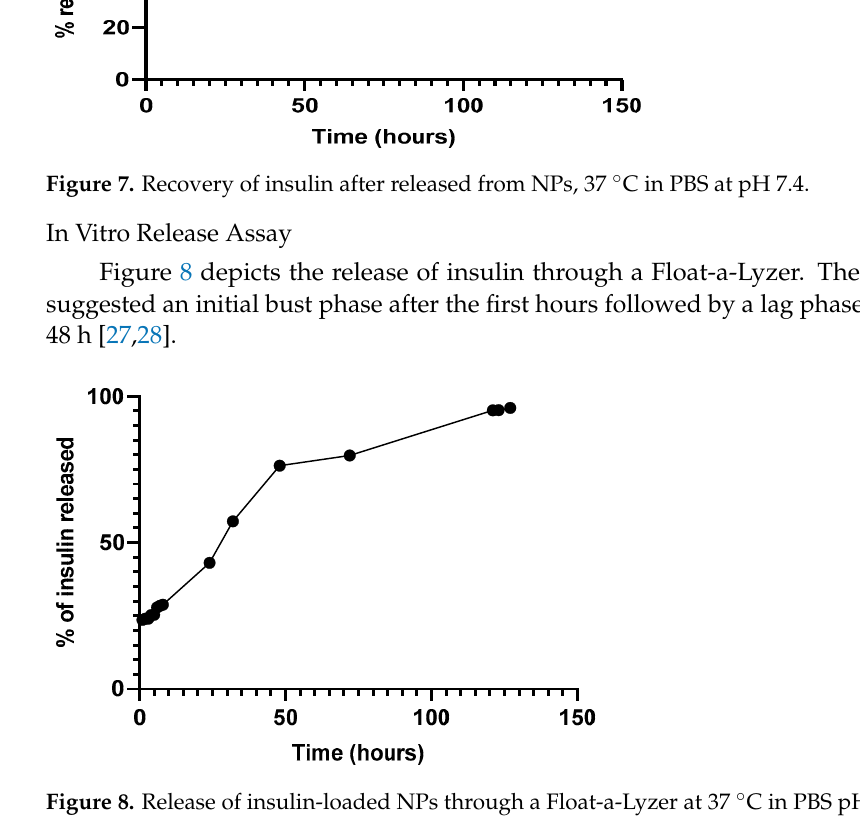
higher release profile (expressed as µg/cm 2 ) for insulin-loaded NPs than for commercial insulin. Both formulations presented a similar release profile, i.e., no significant amount of insulin was released up to 5 h. Then, the amount of insulin released increased in both formulations. Notwithstanding, it is important to highlight that the commercial insulin solution cannot be considered as a control solution, since it is not composed of the same solvents—neither the same insulin concentrations as insulin-loaded polymeric NPs. In fact, commercial insulin is four times more concentrated than NPs formulation. There- fore, both types of vehicles and their compositions varied, affecting the release profile. Figure 9. In vitro release profile through a silicone membrane from insulin-loaded NPs (black line), and a commercial solution of free insulin (grey line) over 8 h expressed in µg/cm 2 (mean ± SD, n = 6). 3.5. Preliminary Safety and Efficacy Assessments 3.5.1. In vitro Safety Assessment Cell viability was assessed by MTT assay. The tetrazole MTT, a yellow water-soluble compound, is converted to a purple, insoluble formazan product by mitochondrial de- hydrogenases and reductase enzymes in active metabolic cells. Thus, the conversion of this product can be directly related to the number of viable (living) cells [29].